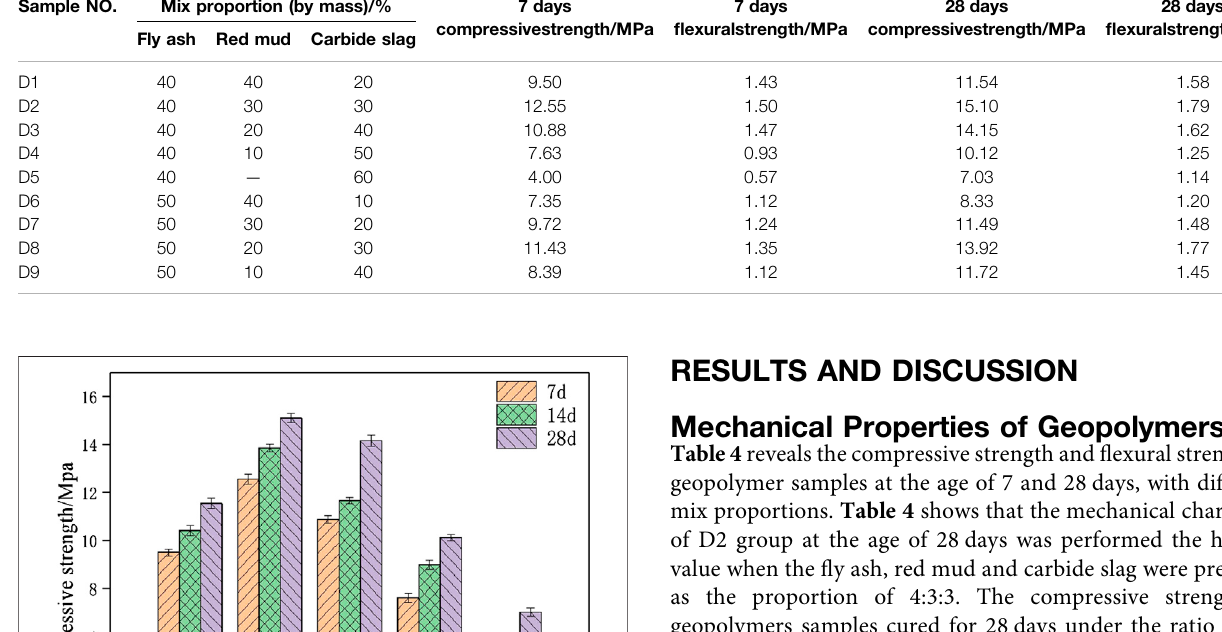
TABLE 4 | The mix proportion of binders and the strength of the geopolymers samples. Sample NO.